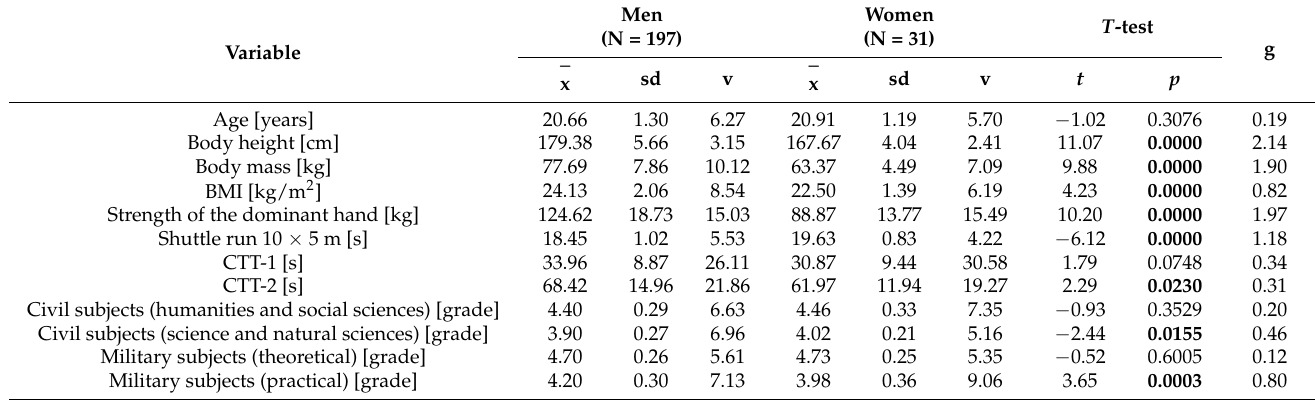
Table 1. Variation in mean values of morphological and motor characteristics as well as AA and attention level by Student’s t -test for independent samples between men and women.